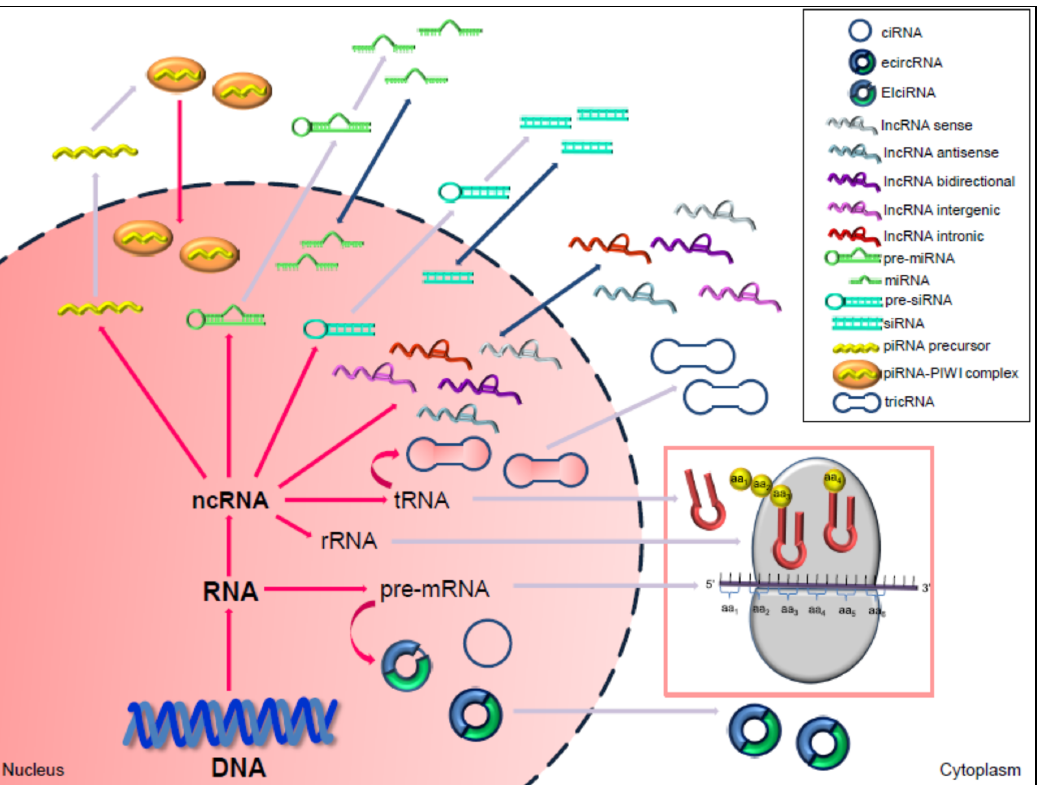
Figure 1. Coding and non-coding classes of RNA. Precursor messenger RNA (pre-mRNA) gives rise to mRNA, which is further translated into protein. Non-coding RNAs (ncRNAs) comprise transfer RNA (tRNA), ribosomal RNA (rRNA), and a large variety of regulatory ncRNAs, including micro RNAs (miRNAs), P-element-induced wimpy testis (PIWI)-interacting RNAs (piRNAs), small interfering RNAs (siRNAs), long non-coding RNAs (lncRNAs) and circular RNAs (circRNAs). Mature miRNAs and siRNAs are transcribed as precursors that undergo a series of nuclear and cytoplasmic processing events, and act in both nucleus and cytoplasm. Similarly, piRNAs are generated from long single-stranded piRNA precursors that are exported in the cytoplasm where they are processed; mature piRNAs are then transported into the nucleus in complex with PIWI. Most circRNAs that derive from linear pre-mRNAs, and are classified in exon-derived circRNAs (ecircRNAs), containing only exons and completely lacking introns, circular intronic RNAs (ciRNAs), which consists of only introns, exon-intron cirRNAs (EIciRNAs), in which one intron is inserted between two exons. RNA circularization can also occur through tRNA intron splicing thus generating tRNA intronic circRNAs (tricRNAs). CiRNAs and EIciRNAs are mainly nuclear, whereas ecircRNAs and tricRNAs are synthesized in the nuclear compartment and then exported to the cytosol. The lncRNAs biogenesis is mostly similar to mRNA, but they are located in the nucleus or cytoplasm, and rarely encode proteins. LncRNAs are classified as sense, antisense, bidirectional, intronic, or intergenic with respect to nearby protein-coding genes.